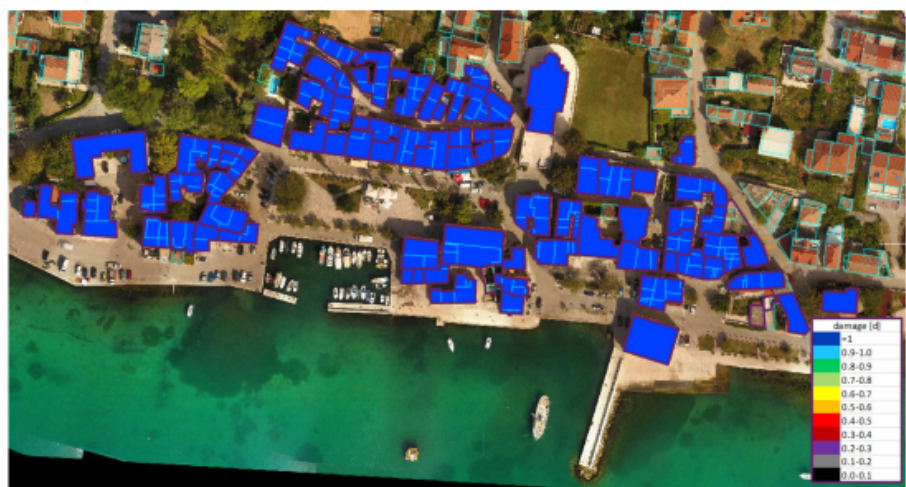
Figure 20. Map of the damage index for PGA = 0.22 g and a return period T = 475